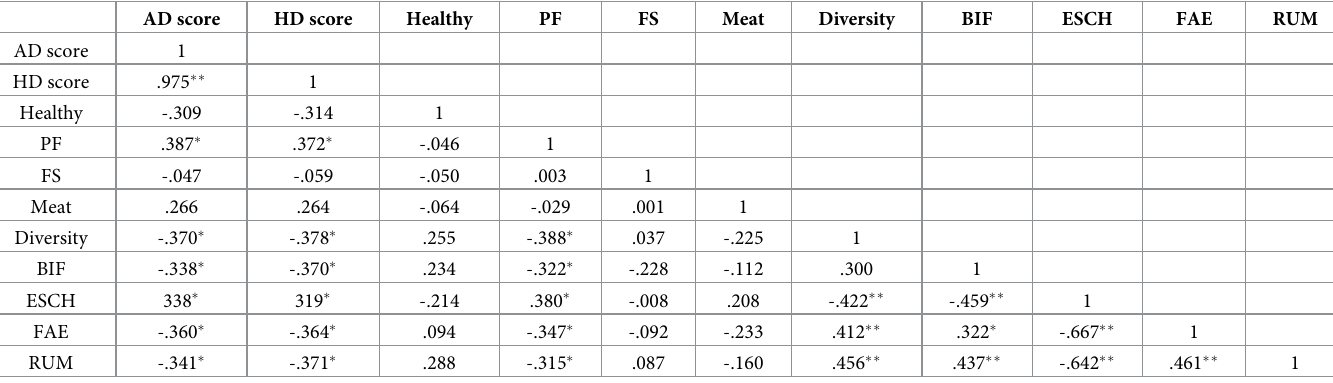
Table 5. Correlation analysis among the dietary pattern, attention deficit hyperactivity disorder (ADHD) score, and gut microbiota composition. AD score HD